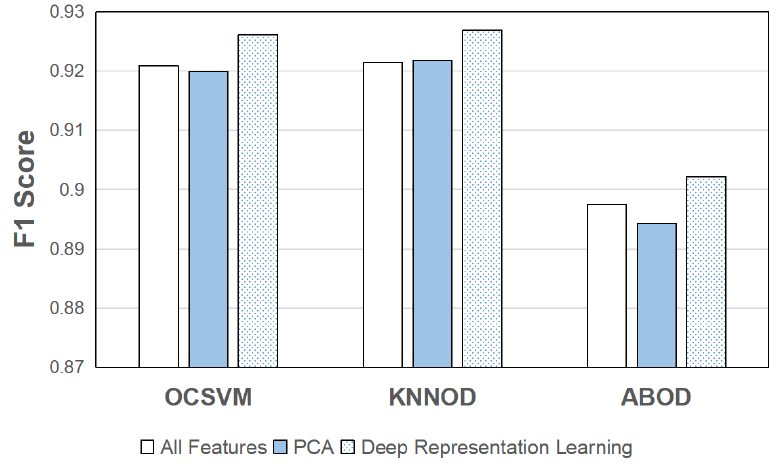
Figure 17. Performance of semi-supervised algorithms with and without feature extraction in terms of average F 1